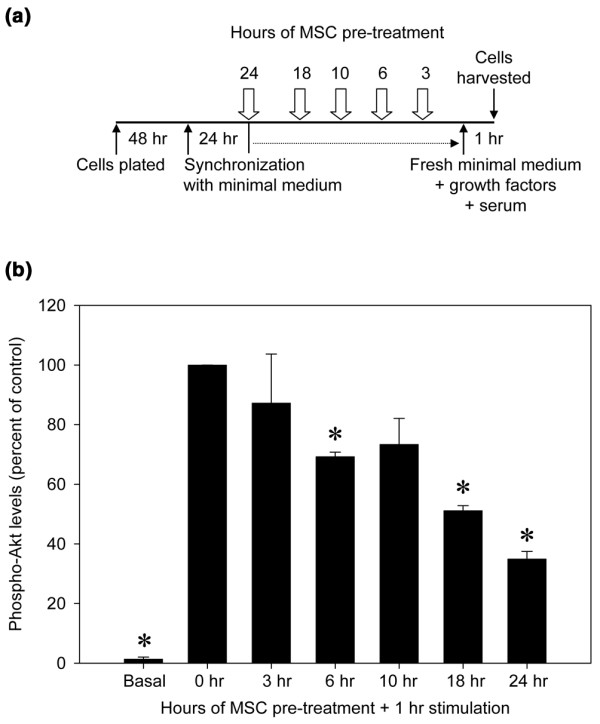
Effect of Se-methylselenocysteine (MSC) on Akt phosphorylation. (a) Scheme for pretreatment of TM6 cells with MSC. Cells were synchronized in minimal medium for 24 hours. Cells were then exposed to 100 μM MSC for 3, 6, 10, 18 and 24 hours in minimal medium before being stimulated with fresh DMEM/F12 medium containing growth factors (5 ng/ml epidermal growth factor and 10 μg/ml insulin) and serum (2% adult bovine serum) for 1 hour. (b) Effect of pretreatment of MSC on Akt phosphorylation in TM6 cells. Equal amounts of lysates (30 μg of protein) were loaded on each lane for each time point. After electrophoresis the immunoblots were probed with anti-phospho-Akt (Ser473) antibody as described in the Materials and methods section, and the levels were measured with Molecular Dynamics software. Each bar represents levels in TM6 tumor cells treated with MSC in three different wells. *P < 0.05 compared with 0 hours.